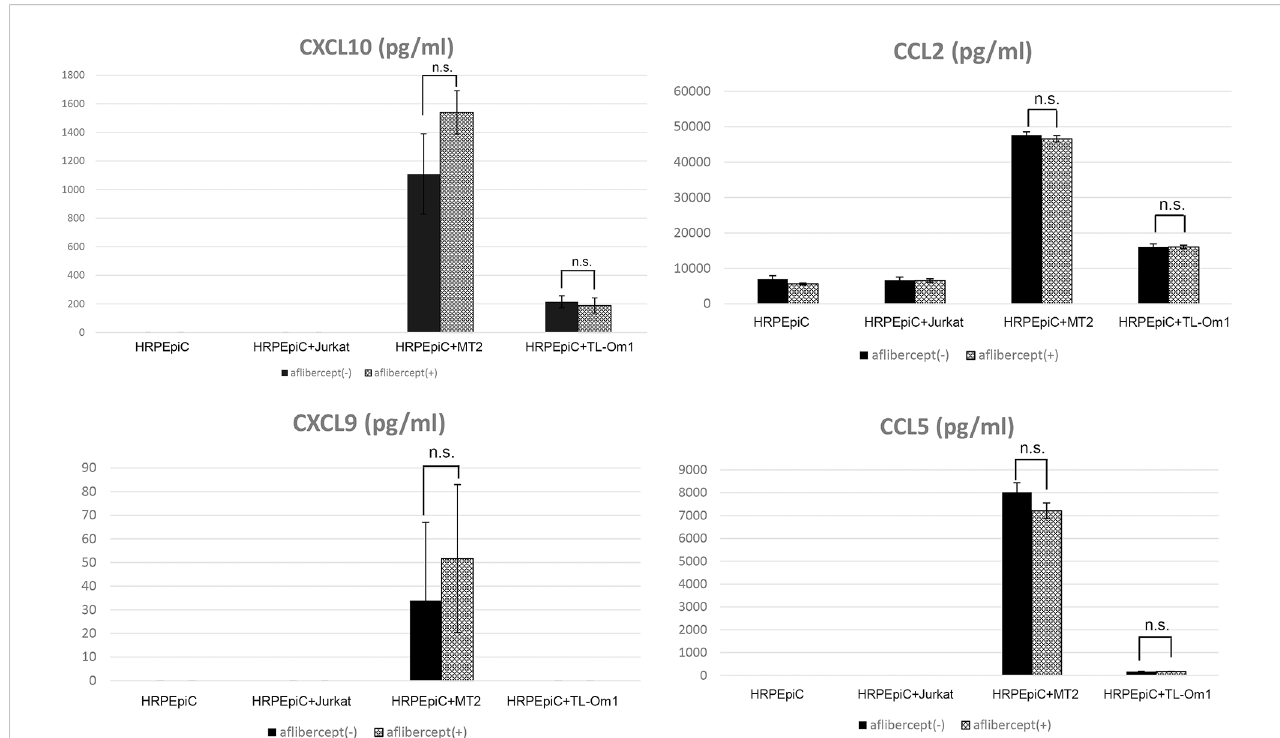
FIGURE 4 Levels of chemokines measured in the culture supernatants of HRPEpiCs and HRPEpiCs co-cultured for 48 h with MT2, TL-Om1, or Jurkat cells with/ without 0.5 mg/mL a fl ibercept. Secretion of CXCL10, CCL2, CXCL9, and CCL5 was monitored, but no signi fi cant differences were detected in all corresponding groups, with or without a fl ibercept. Data are taken from three independent biological experiments and presented as the mean ± SEM (units: pg/ m L) (n.s., not signi fi cant).